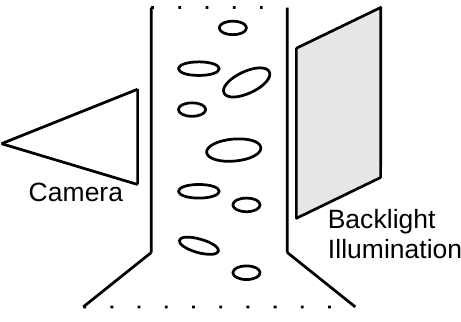
Figure 1: Drawing of a typical